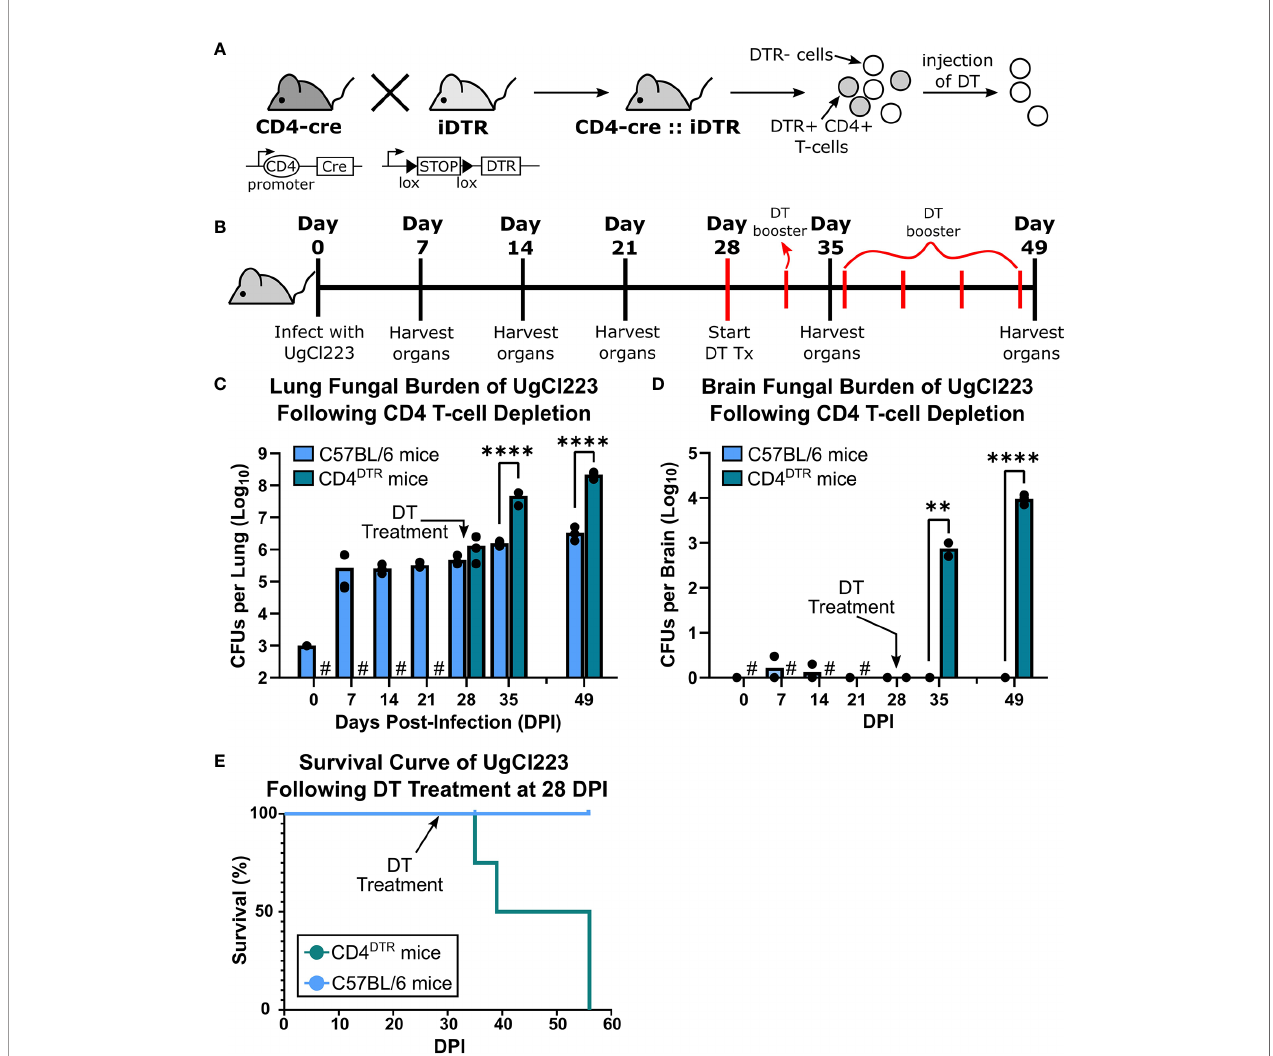
FIGURE 6 | Diphtheria toxin (DT) treatment ablated CD4+ T-cells in CD4 DTR mice and caused lethal UgCl223 infections. (A) Scheme showing generation of CD4 DTR mice and CD4+ T-cell ablation. A cross of CD4-cre mice to iDTR mice generate mice that contain CD4 T-cells sensitive to diphtheria toxin (DT). Filled triangles = loxP sites; arrows = transcriptional activity; open oval = promoter. (B) Experimental timeline showing CD4 DTR and C57BL/6 mice were intranasally infected with UgCl223 and treated with DT starting at 28 days post-infection. Mice received a booster dose of DT every 4 days to maintain CD4 depletion. (C) Lungs and (D) brain were analyzed for CFUs at 0-, 7-, 14-, 21-, 28-, 35- and 49-days post-infection. # = no CFUs were determined for timepoints prior to 28-days post-infection for DT- treated CD4 DTR mice. Black arrows indicate start of DT treatment. n = 3 mice per timepoint per group. (E) Mice were monitored for signs of morbidity and sacri fi ced at natural endpoint (20% total weight loss, 1g/day weight loss for 2 consecutive days, or neurological symptoms including loss of sternal recumbency, partial paralysis, seizure, convulsion, or coma). n = 4-5 mice per group. For CFU analysis, **p < 0.001, ****p < 0.00001 by two-way ANOVA. For survival kinetics, p=0.0075 by log-rank